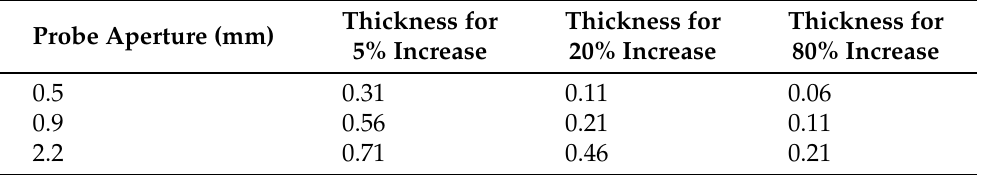
Table 9. Thickness of three different increase levels for retrieved relative permittivity of skin–olive oil double-layered configurations at 4 GHz with three different